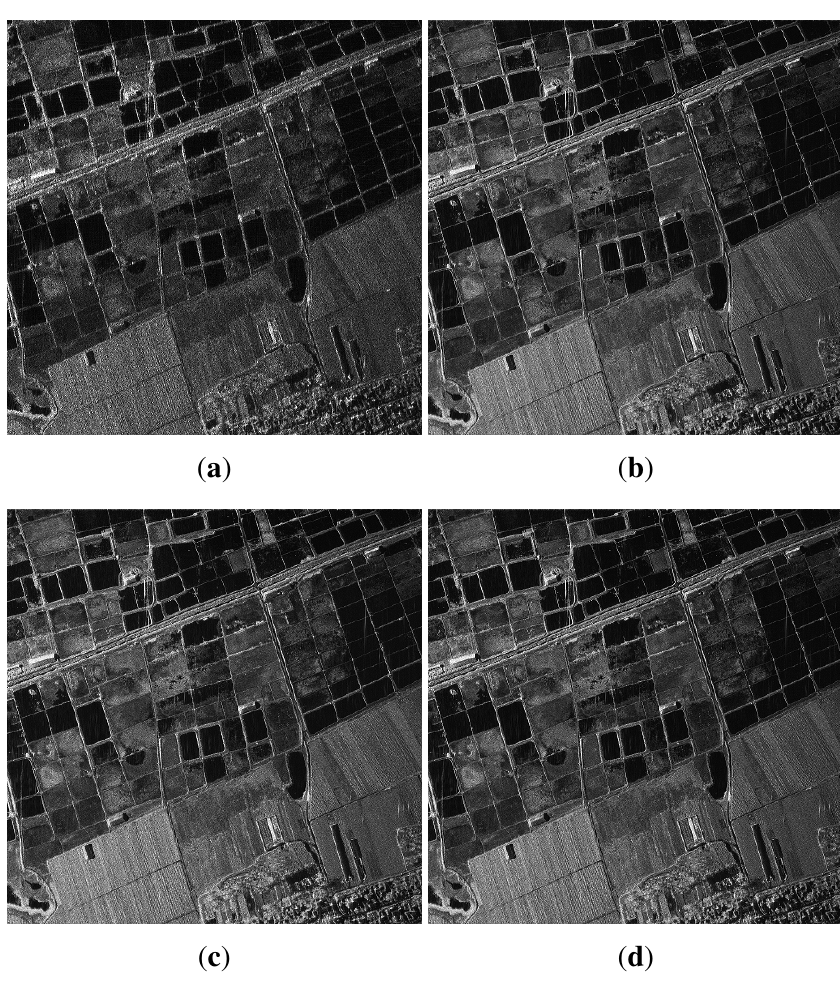
Figure 10. Results of real SAR imaging without strong point target: ( a ) imaging result of sub-band signal; ( b ) imaging result of reconstruction with relative calibration; ( c ) imaging result of reconstruction of first-order TRPGA; ( d ) imaging result of reconstruction of two-order TRPGA.